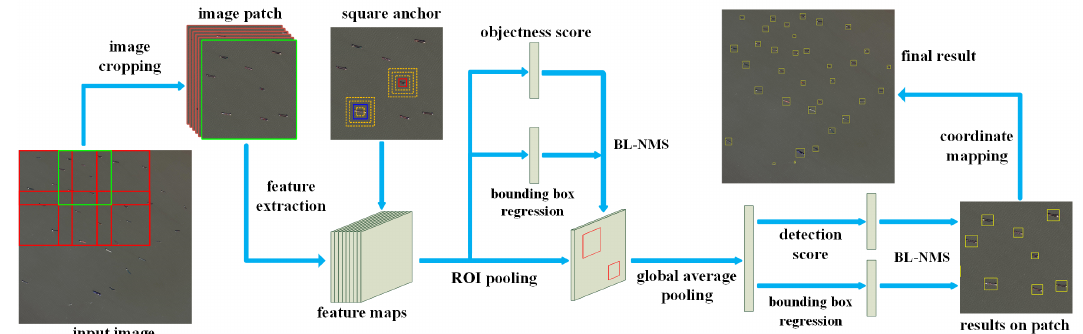
Figure 2. The process of on-board ship detection based on deep